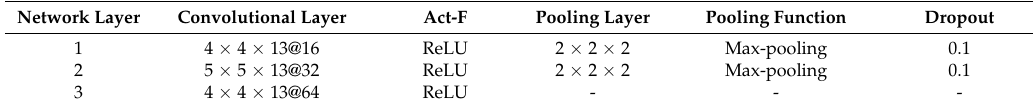
Table 3. Parameters in the PO-3DCNN method.